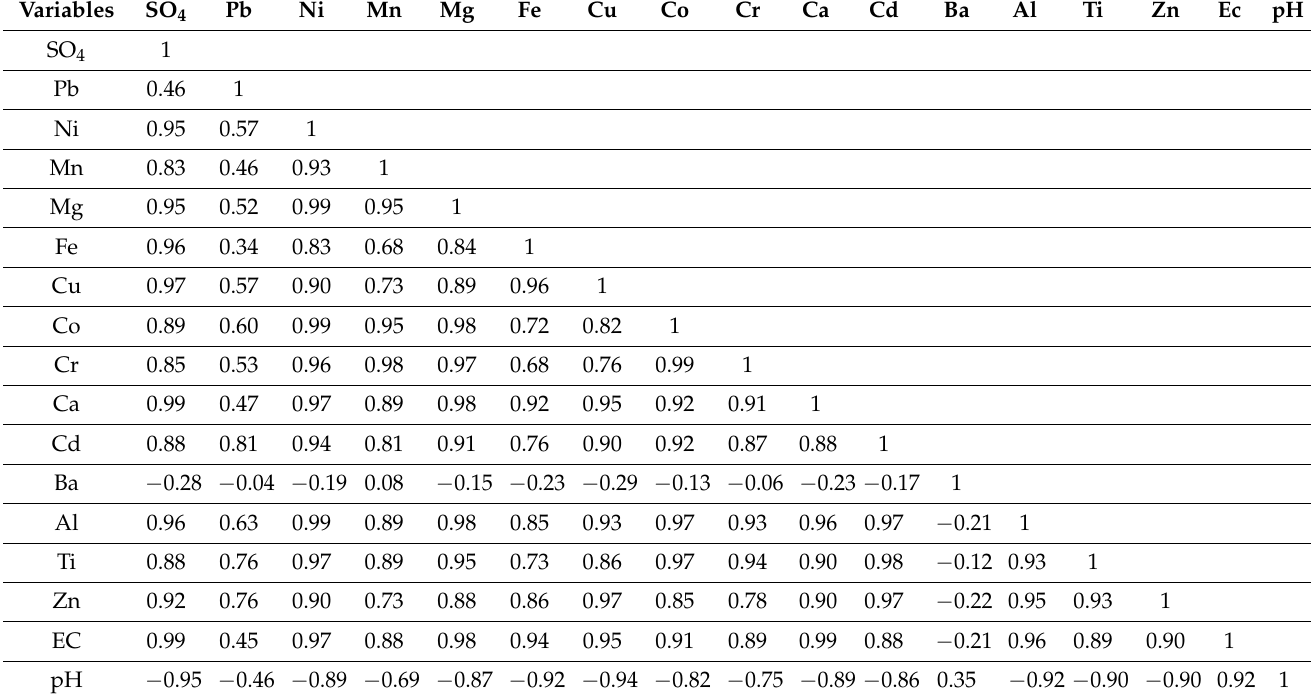
Table 4. Correlation between variables and factors (F1 and F2) from observation wells installed in 2011 (first